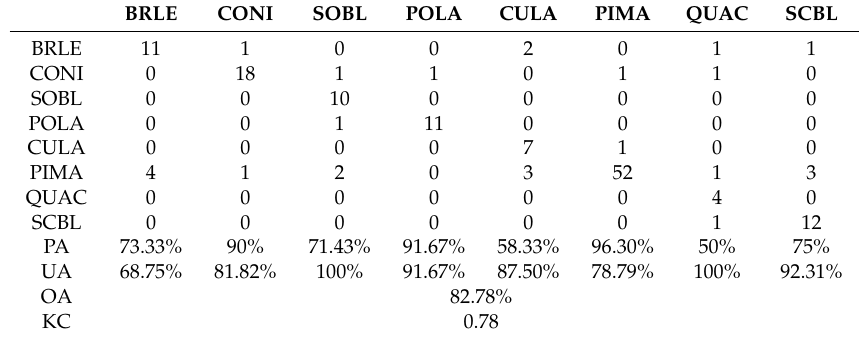
Table 10. Confusion matrix for forest type identification with the highest accuracy from Scenario 5.